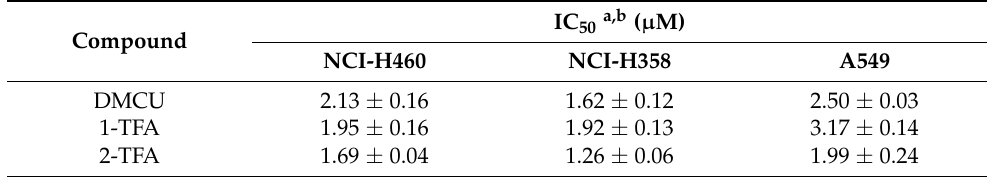
Table 1. The anti-proliferative effects of DMCU, 1-TFA, and 2-TFA against NCI-H460, NCI-H358, and A549 lung cancer cell